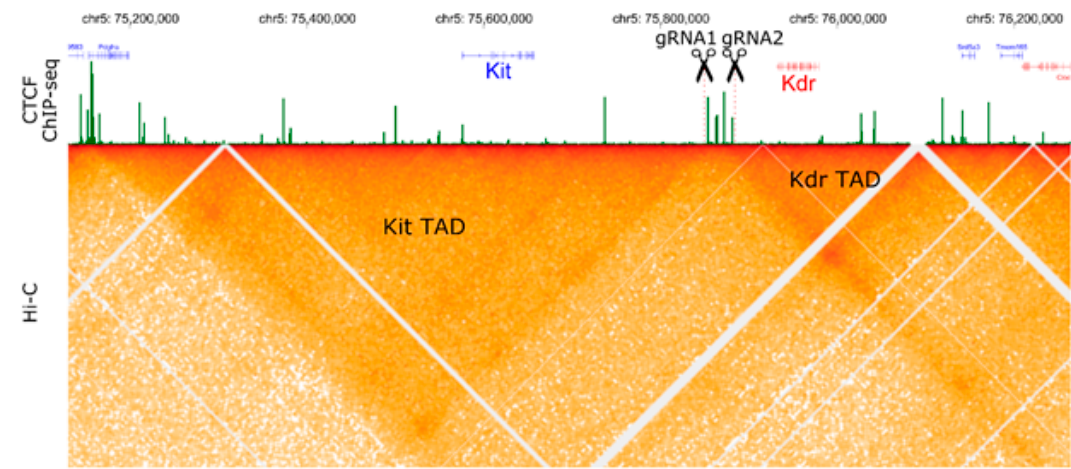
Figure 1. Three-dimensional organization (Hi-C map) and localization of CTCF binding sites (ChIP-seq) for Kit / Kdr genomic locus in mouse embryonic stem cells, according to [57]. Two gRNAs were selected to delete four CTCF binding sites in the intergenic region between the Kit and Kdr genes.